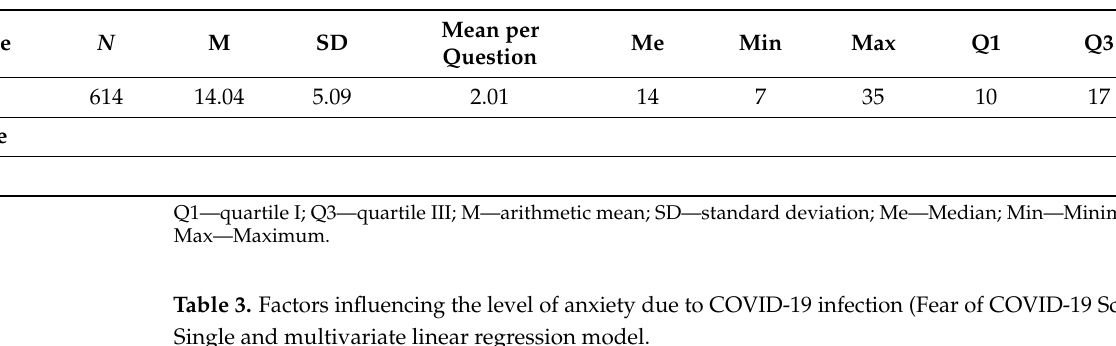
Table 2. Fear of COVID-19 Scale–scores ( N = 614).